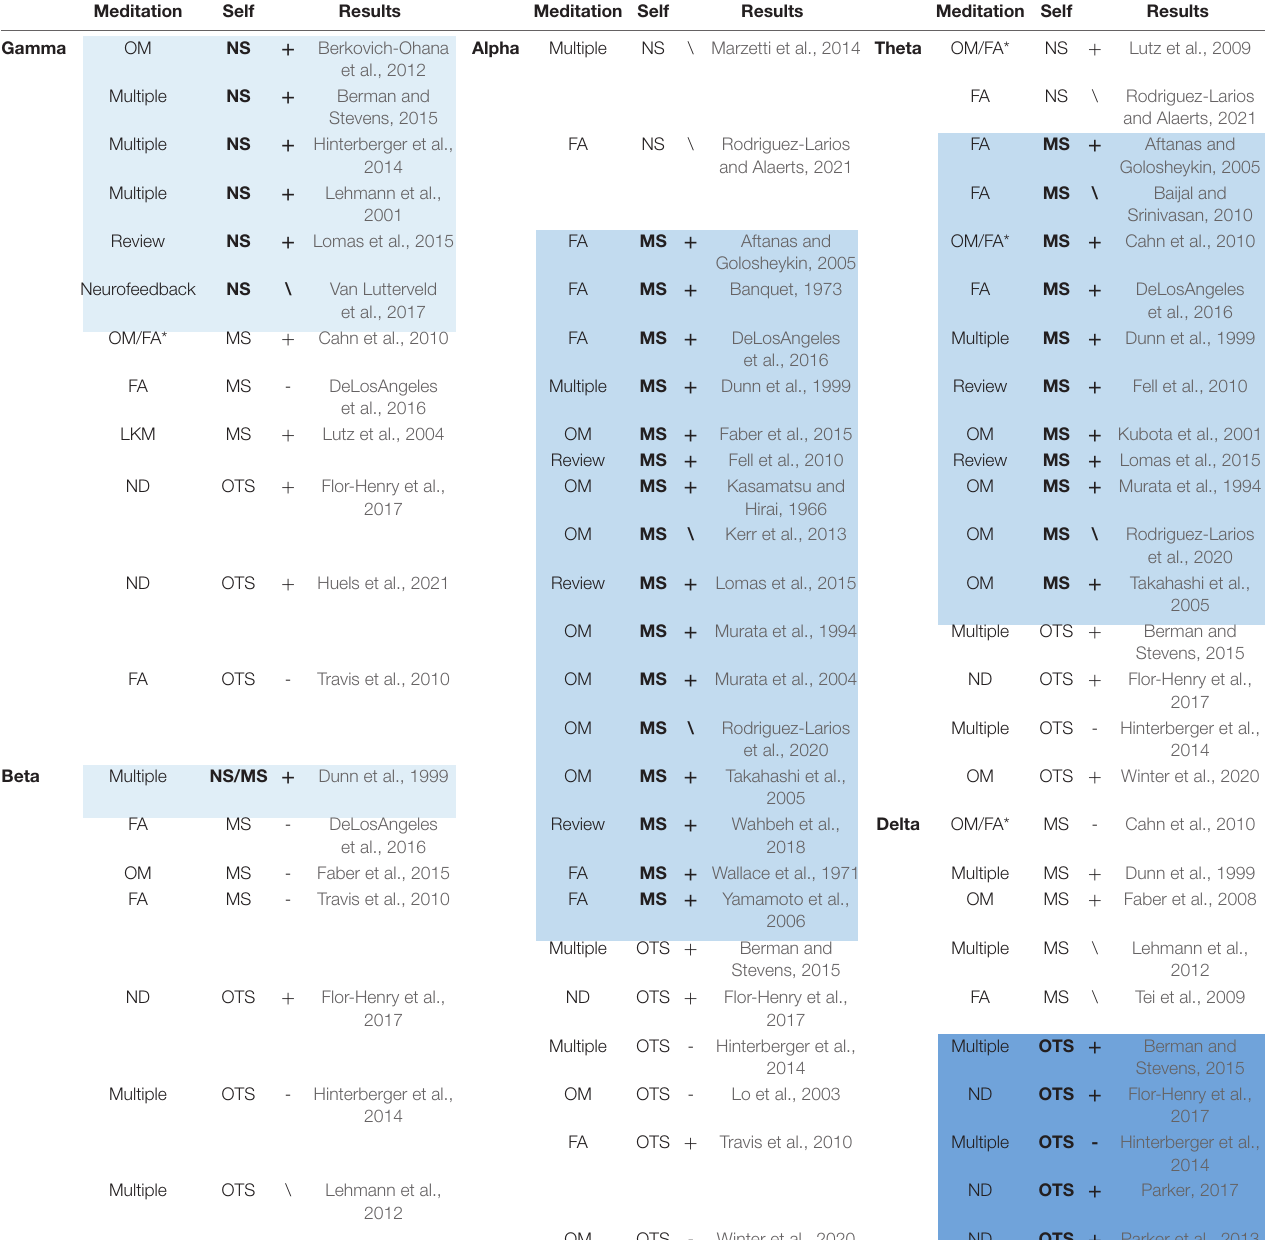
TABLE 1 | Synthesis table summing our mini-review linking different meditation practices and the phenomenological description of the Selves to the electrophysiological findings. Meditation Self Results Meditation